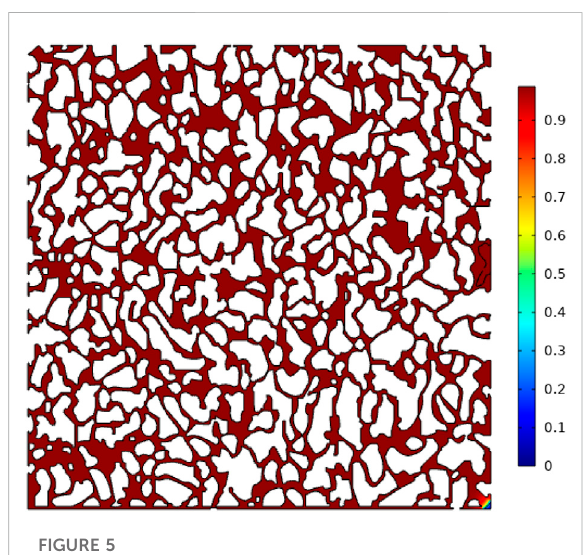
FIGURE 5 Initial oil-water